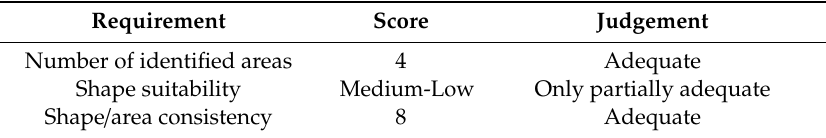
Table 7. Assessment of the criterion: subdivision by fauna.